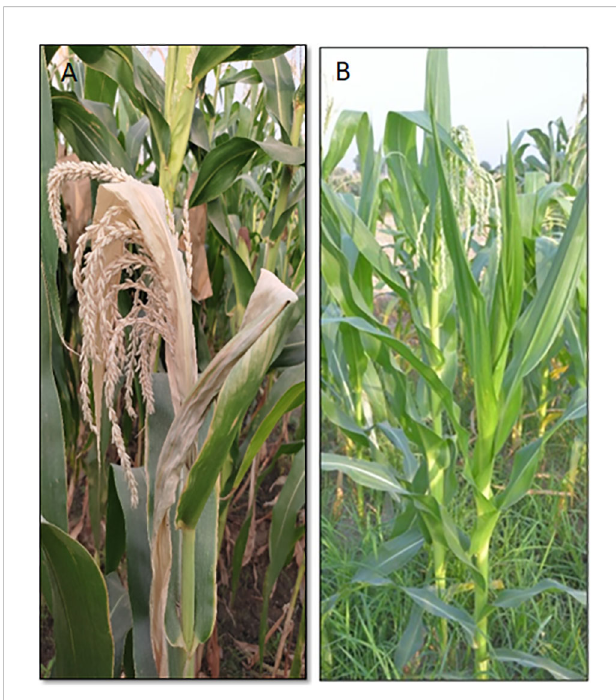
FIGURE 1 The maize inbred lines used in the present study. (A) LM 11 (Heat susceptible). (B) CML25 (Heat